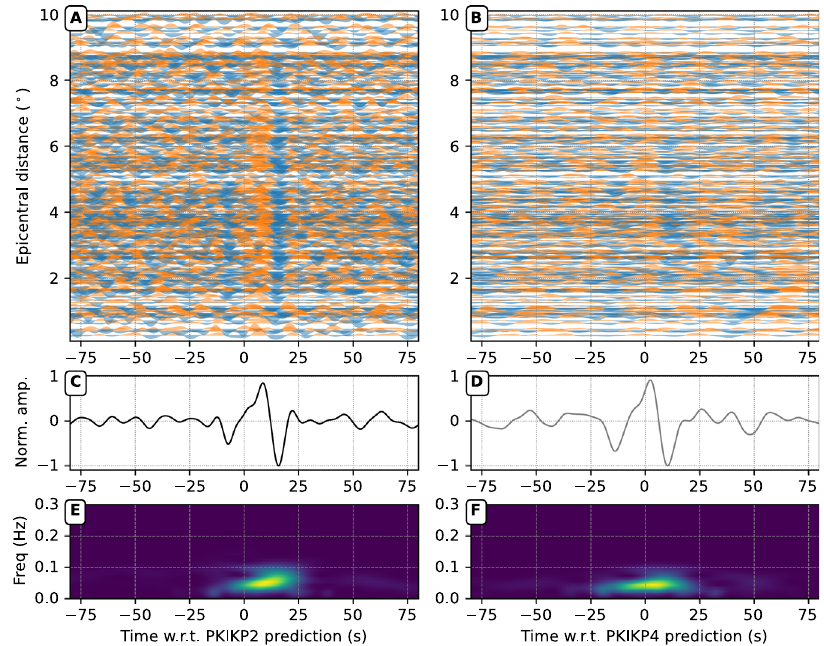
Fig. 5 | Observations of second and fourth PKIKP multiples, i.e., PKIKP2 and PKIKP4, respectively, in the seismic wave fi eld from the 30 Nov 2018, Mw 7.1 Anchorage earthquake. A Seismic records from the Alaskan network are aligned with the predictions of PKIKP2 arrivals, corrected by the Earth ’ s ellipticity 69 . The